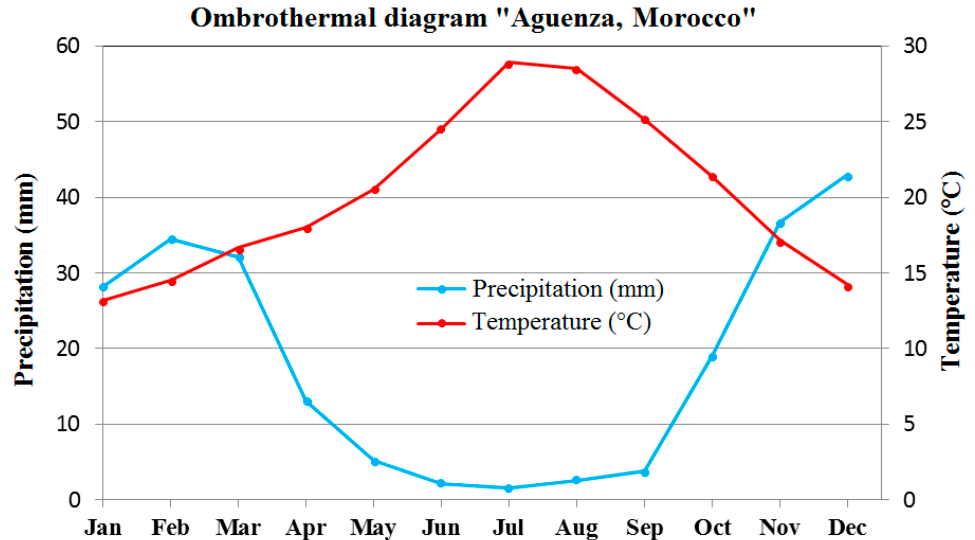
Figure 3. Ombrothermal diagram of the Aguenza watershed for the observation period: 1982–2011 (scale: P = 2 T).